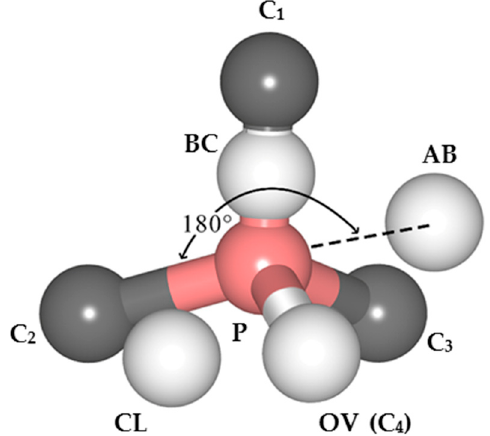
Figure 5. The possible H sites around a PV complex.